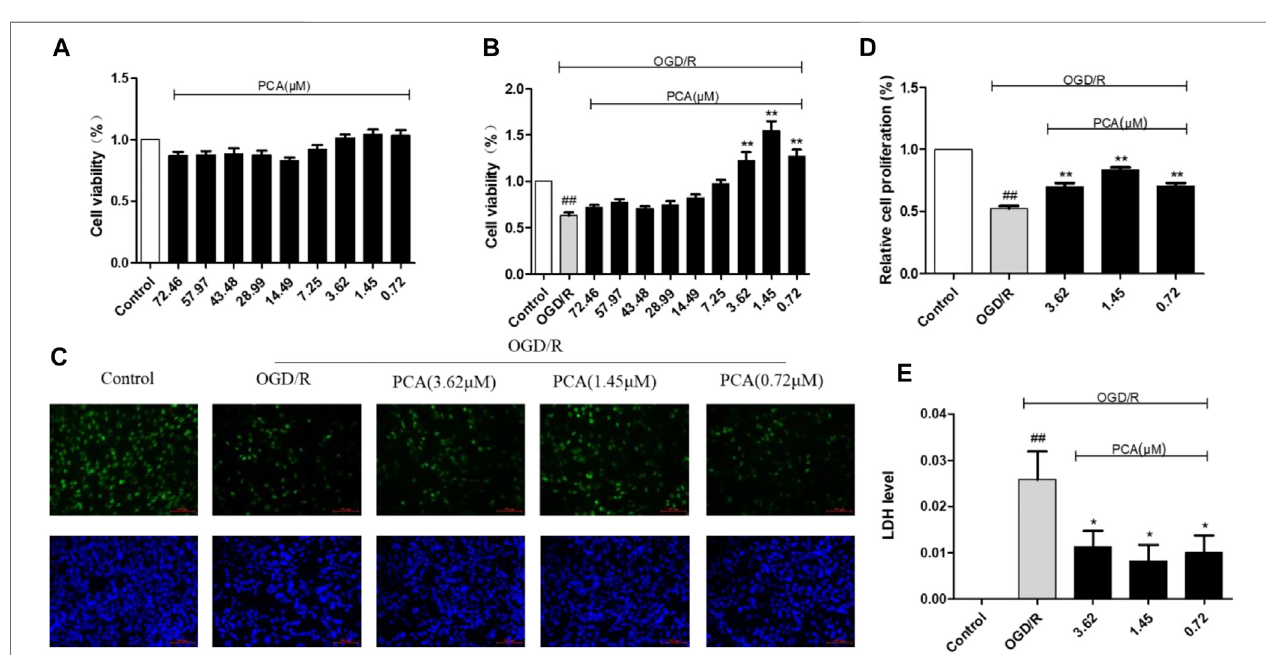
FIGURE2| PCA protects HUVECs against OGD/Rinjury. (A) HUVECs weretreatedwithdifferentconcentrationsofPCA(0.72 – 72.46 μ M) for24 h, andmeasured cellviabilitywithCCK-8; (B) HUVECsweretreatedwithOGDfor10 h,incubatedifferentconcentrationsofPCA(0.72 – 72.46 μ M)for24 h,andmeasuredcellviabilitywith CCK-8. (C) TherateofcellproliferationinHUVECswasdetected usinganEDUcellproliferationassay; (D) PCAreverses OGD/R-induced HUVECs cellproliferationrate. (E) TherelativeLDHlevelinHUVECswasdetected usinganLDHassay.Thevaluesareexpressed asthemean±SD( n =3). ## p < 0.01vs.Control,** p < 0.01,* p < 0.05 vs.